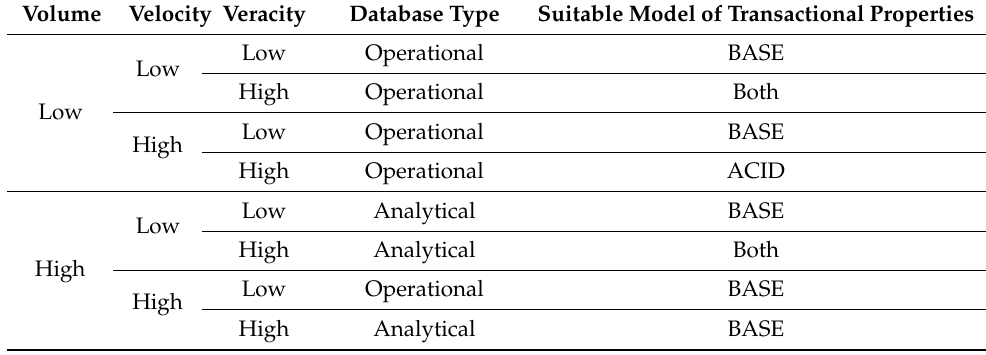
Table 2 also includes the type of database—analytical or operational—where the scenario is more likely to be observed. Table 2. Most suitable model of transactional properties according to the volume, velocity, and veracity of data.